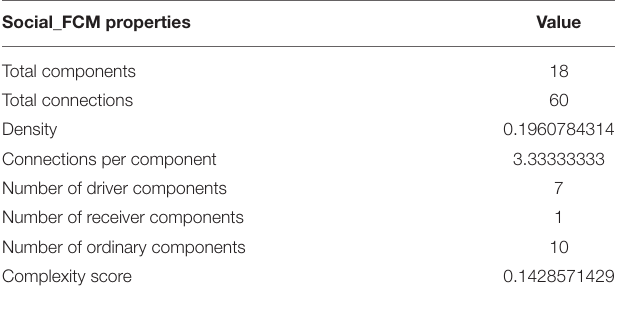
TABLE 3 | General Social_FCM Statistics.